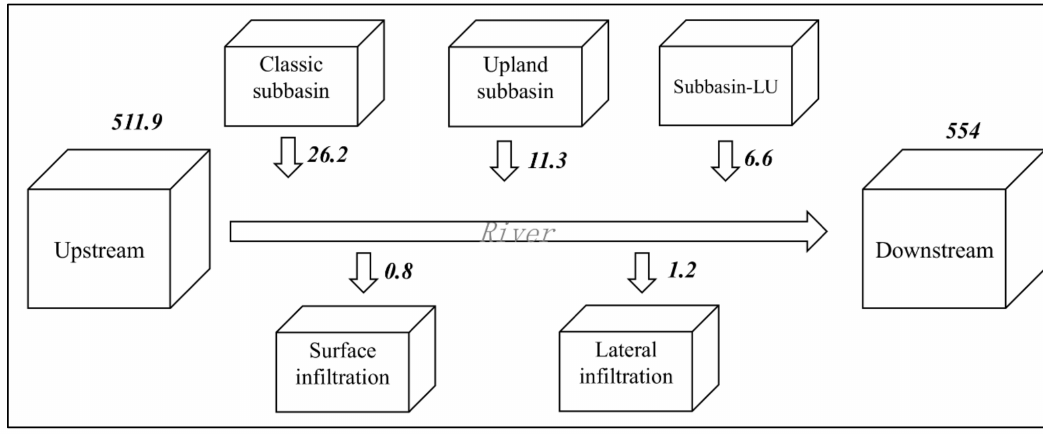
Figure 4. Annual water balance in the study area (unit is 10 7 m 3